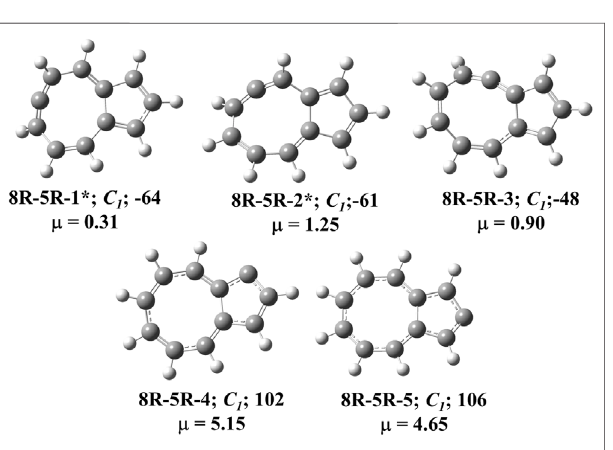
FIGURE 4 | All low-lying C 11 H 8 carbenes/cyclic allenes isomers of (8R- 5R) group. ZPVE-corrected relative energies (in kJ mol − 1 ), absolute dipole momentvalues(in Debye)arecalculatedattheB3LYP/6-311 +G(d,p)levelof theory. Experimentally detected isomers are marked with an asterisk